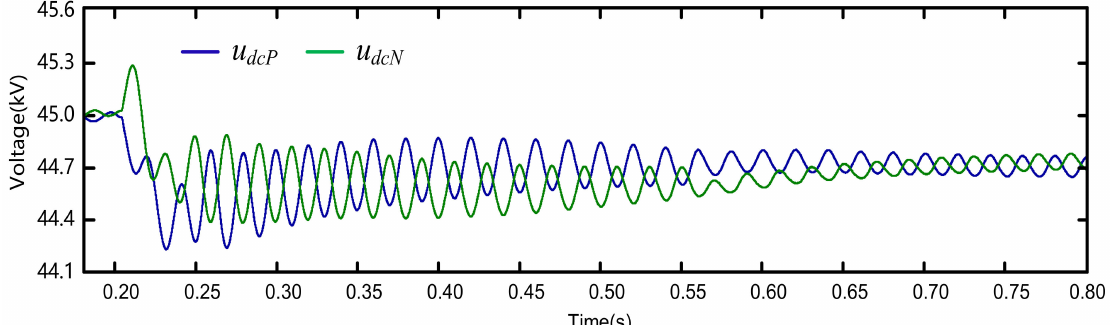
Figure 9. Voltages of common DC